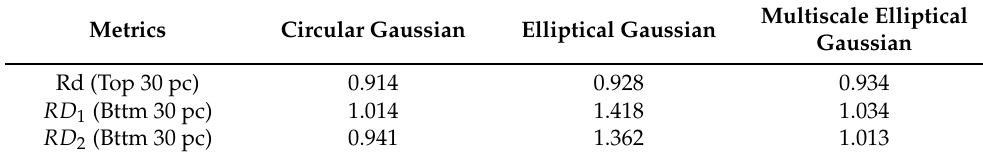
Table 3. Recall Rate for Small Ships and Repeated Detection Rate for Large Ships. Metrics Circular Gaussian Elliptical Gaussian